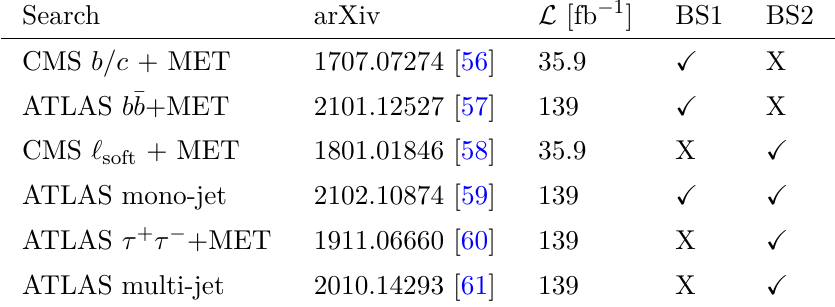
Table 2 . List of MET searches at the LHC considered in this work. We indicate whether they can target the BS1 and BS2